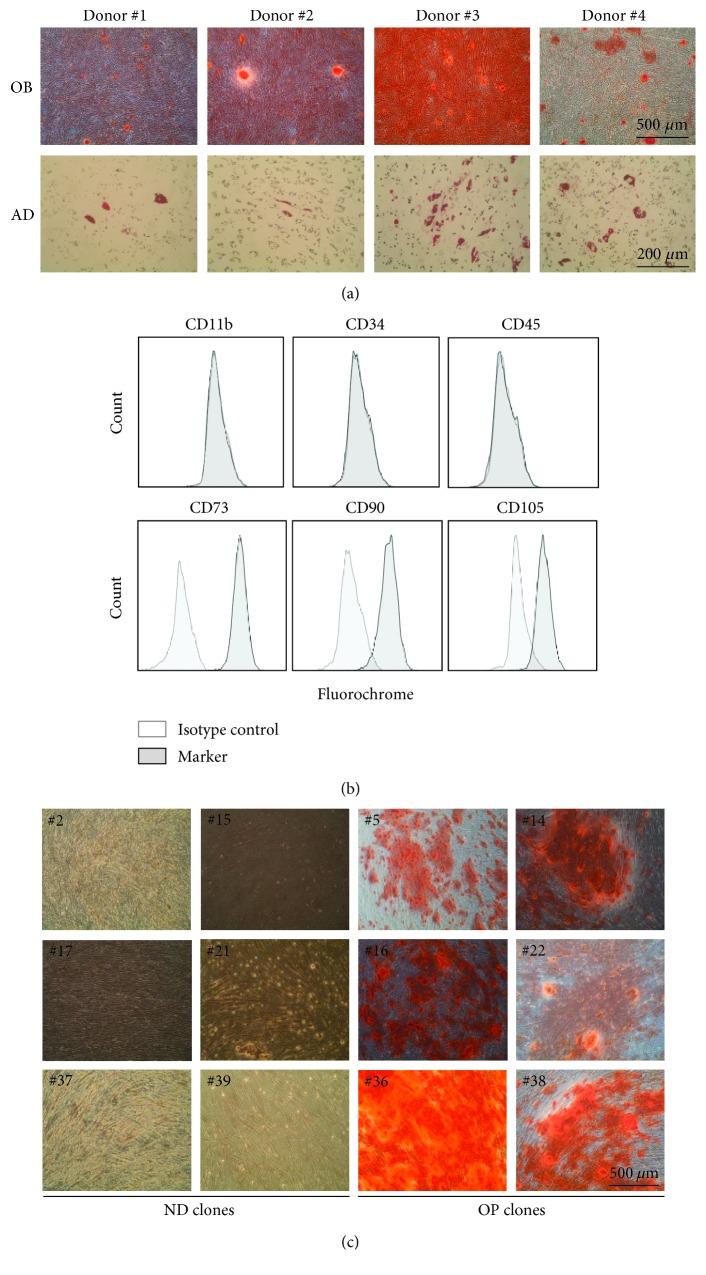
Generation of monoclonal T-MSC subpopulations. (a) Osteogenic (OB) and adipogenic (AD) differentiation was induced in T-MSCs from four different donors. Matrix mineralization and lipid droplet formation were examined by Alizarin red S and oil red O staining, respectively, under phase-contrast microscopy (100x magnification for OB and 200x magnification for AD). (b) Surface marker expression in T-MSCs selected for further single-cell cloning was examined by flow cytometry. (c) OB differentiation was induced in monoclonal cells, and Alizarin red S staining was used to assess matrix mineralization. Representative images of six nondifferentiating (ND) and six osteoblast-prone (OP) clones were shown (100x magnification).